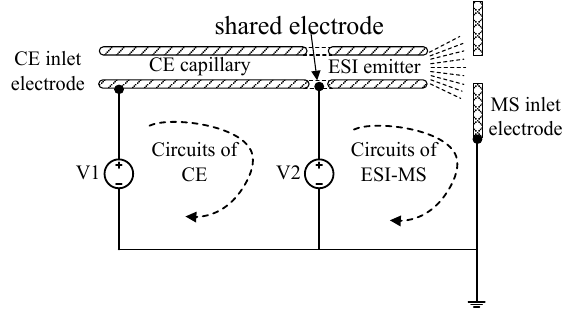
Figure 1 Electrical perspective of a CE-ESI-MS